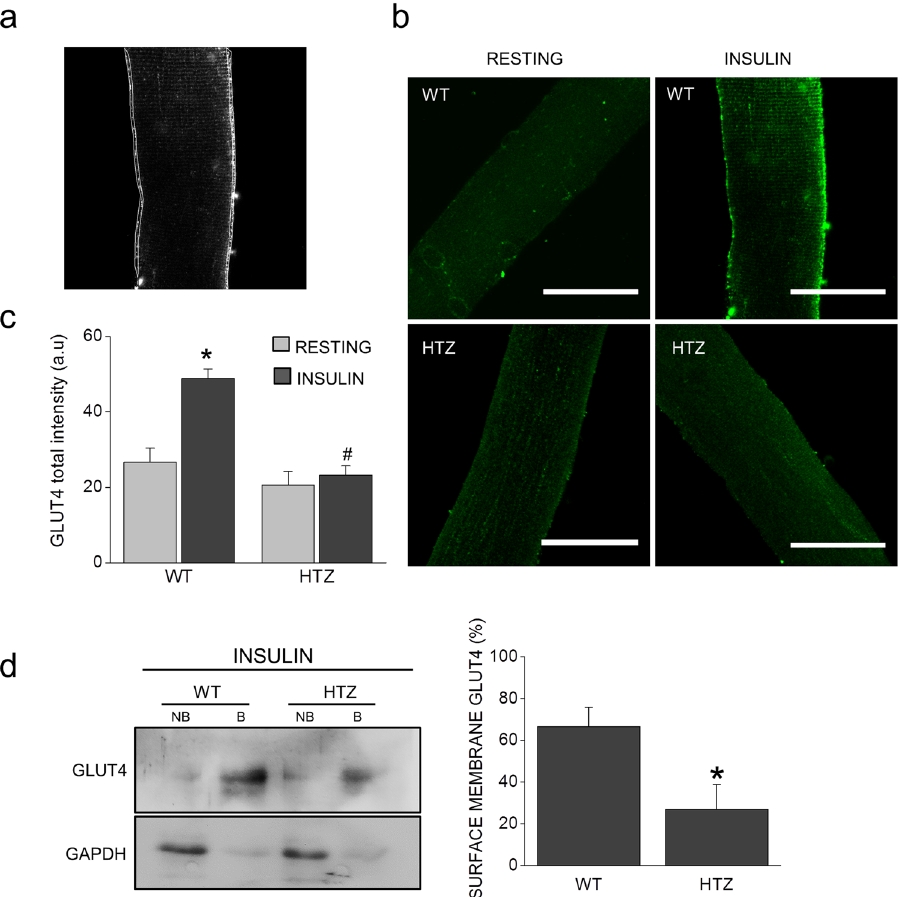
Figure 6. Insulin-induced translocation of GLUT4 is disrupted in muscle fibers isolated from HTZ mice. ( a–c ) Freshly dissected FDB muscles from 2 month-old WT and HTZ mice were digested with collagenase. Isolated fibers were stimulated during 15 min with 0.1 µ M insulin to induce GLUT4 translocation, fixed and immunolabeled with a polyclonal-GLUT4 antibody. Translocation of GLUT4 was estimated by measuring the total intensity fluorescence of GLUT4 in ROIs at the sarcolemma. ( a ) Examples of the ROIs used are drawn in white. GLUT4 was measured on both edges of the confocal image and then averaged. ( b ) Examples images of GLUT4 signal in WT and HTZ fibers at the resting (left panels) and insulin-stimulated condition (right panels). Scale bar = 20 µ m. ( c ) The graph show the averaged GLUT4 signal in sarcolemma. Note that insulin-induced GLUT4 translocation is significantly reduced in HTZ myofibers compared to WT myofibers. Data are expressed as mean GLUT4 fluorescence signal ± SEM. Statistical comparisons were performed utilizing a two-tail t-test Welch corrected for parametric data. The symbols * and # denote significance with respect to WT-resting and WT-insulin-stimulated fibers, respectively. N is between 34 and 66 fibers from at least 10 different animals per genotype. ( d ) FDB muscles were dissected from WT and HTZ mice, stabilized in Tyrode solution, stimulated for 30 min with 0.1 µ M insulin and then exposed to 1 mg/ml of biotin at 4 °C during 60 min. After quenching with 100 mM glycine, muscles were frozen and pulverized in liquid nitrogen, lysed and centrifuged at 14.000 g for 10 min. Supernatants were mixed with streptavidin-agarose beads overnight at 4 °C and then centrifuged at 14.000 g for 3 min. Biotinylated and non-biotinylated fractions were used to evaluate GLUT4 expression by western blot. GAPDH was used as a control that only surface proteins were labeled in biotinylated fractions. On the left are shown representative blots per each condition, on the right are plotted the percentages of GLUT4 in biotinylated fractions. Data are expressed as mean GLUT4% ± SEM. Statistical comparisons were performed utilizing a two-tail t-test Welch corrected for parametric data. The symbol * denote significance with respect to WT-muscles. N is five different animals per